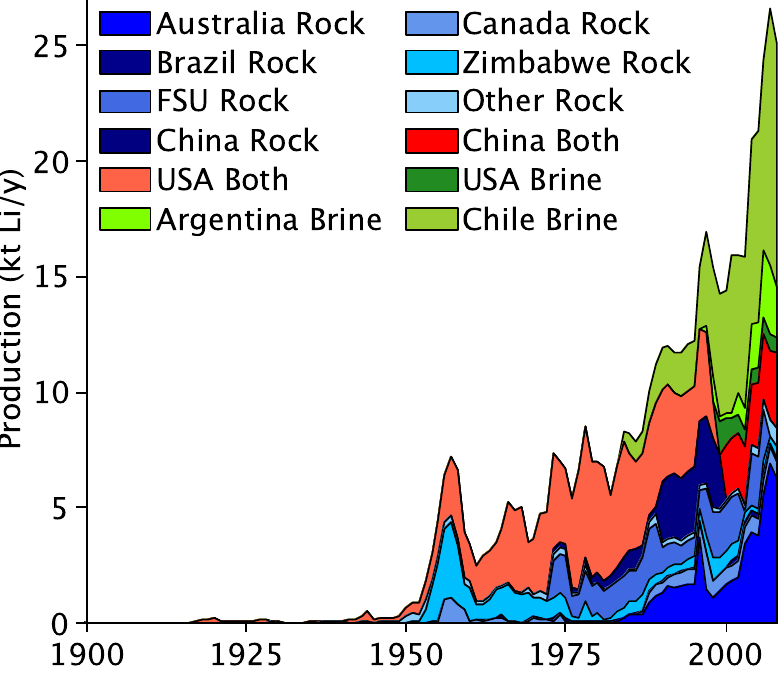
World production of lithium by country and mineral type (blue colours are rock, green colours are brines and red colours contain both rock and brine—see electronic supplement for a spreadsheet file of these values)